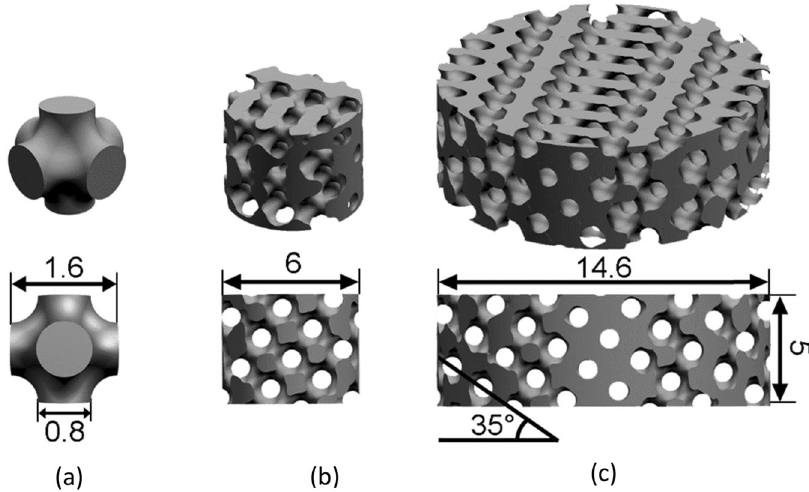
Fig. 1 CAD designs used for scaffold manufacturing. Measurements are in